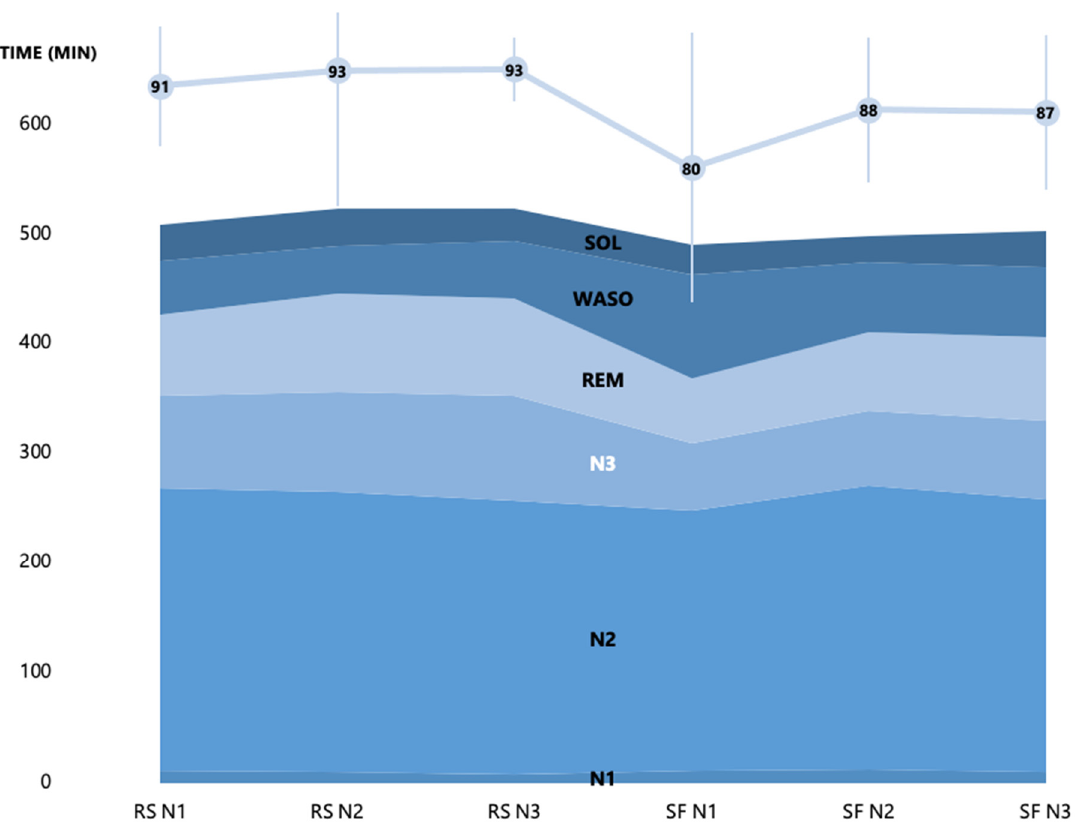
Figure 4. Sleep architecture and sleep efficiency across the three nights in each sleep condition. RS = regular sleep; SF = sleep fragmentation; SE = Sleep Efficiency. SOL = Sleep Onset Latency; WASO = Wake After Sleep Onset; REM = time spent in REM stage; N3 = time spent in N3 stage; N2 = time spent in N2 stage; N1 = time spent in N1 stage.